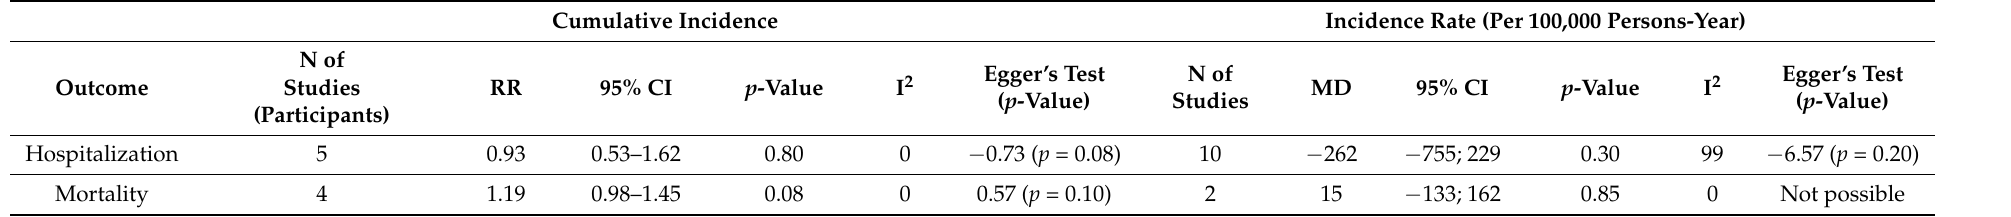
Table 2. Meta-analysis of hospitalization and mortality rate between RSV and